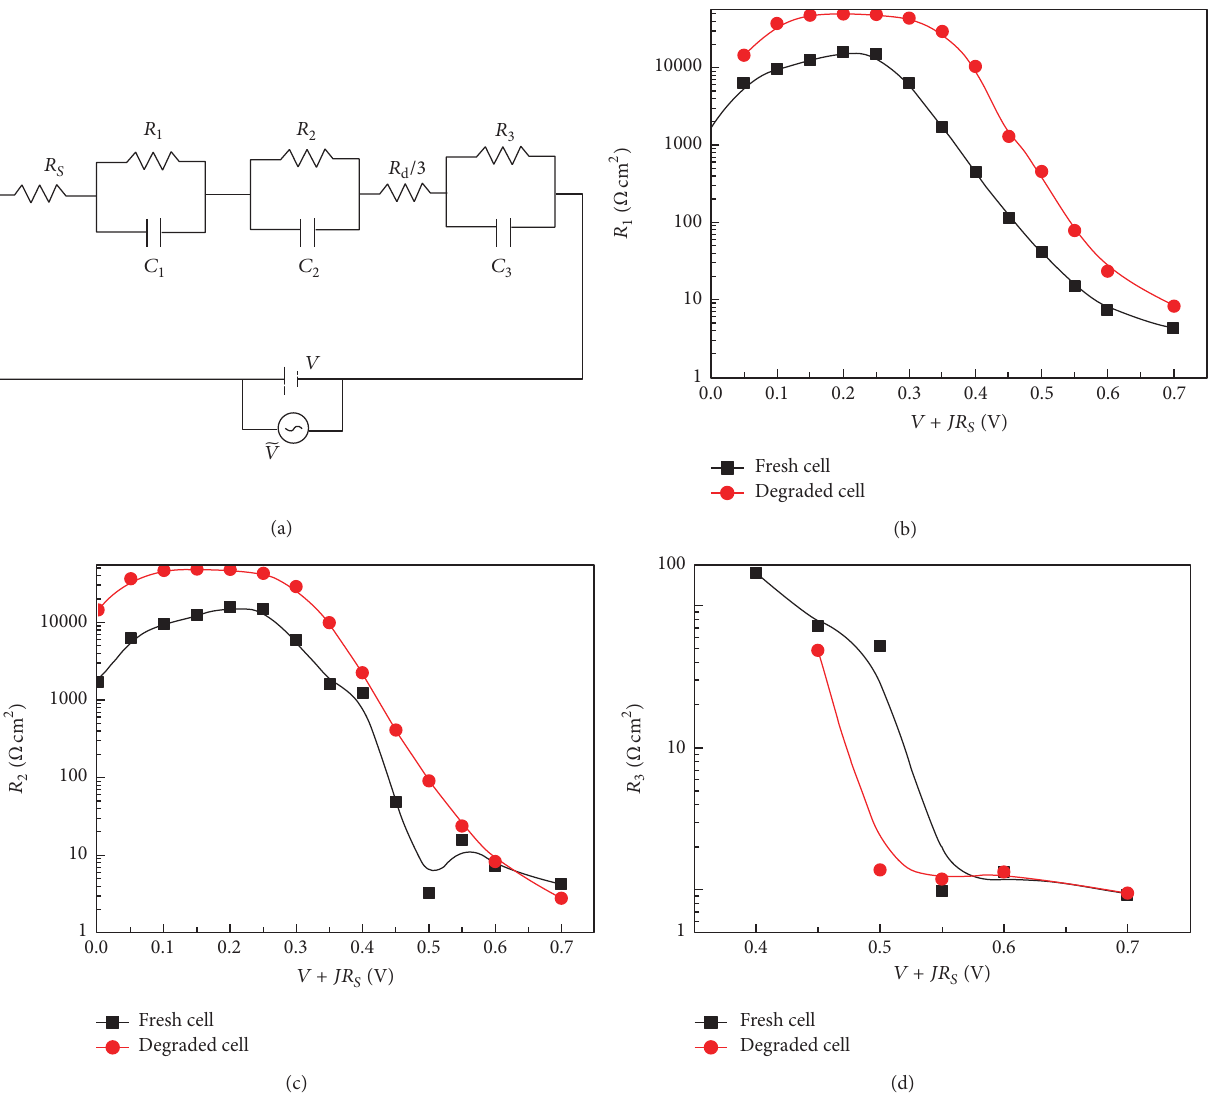
Figure 6: (a) Equivalent circuit used for fitting EIS. Variation of resistances (b) 𝑅 1 , (c) 𝑅 2 , and (d) 𝑅 3 as a function of applied bias,